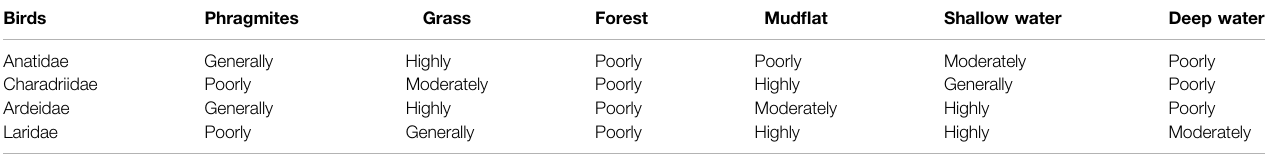
TABLE 1 | Suitability grade of land cover types for different migratory bird guilds in DL (Tian et al., 2008a; Wu et al., 2019b).